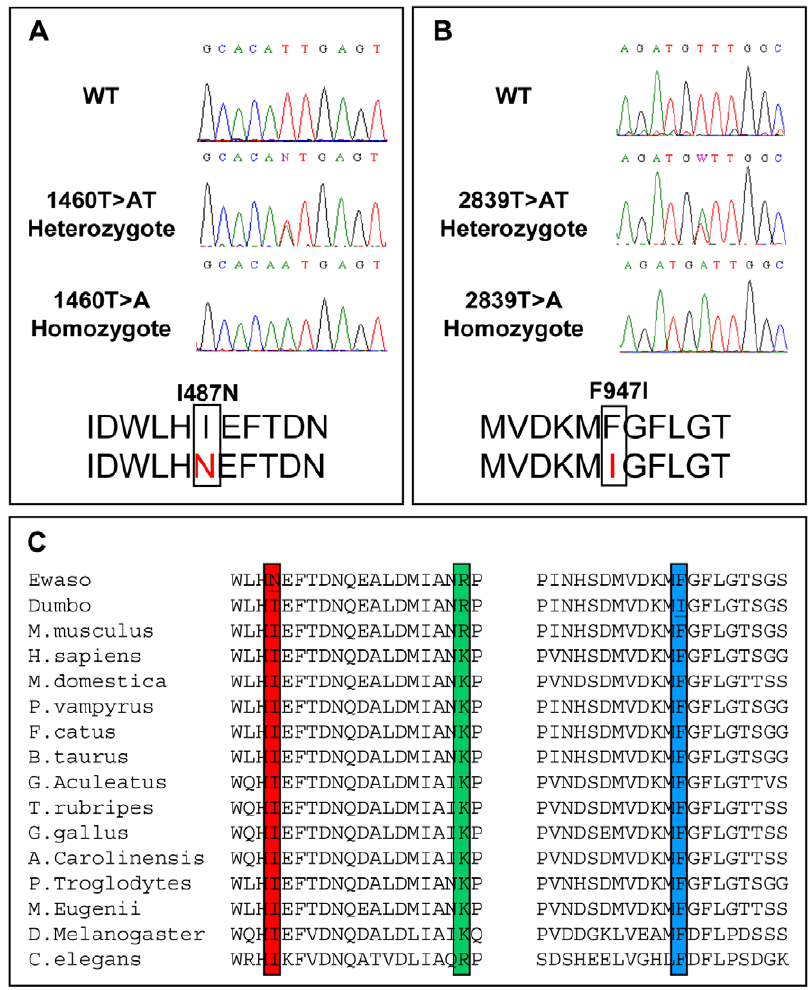
Figure 2. Myo7a mutations identified in Myo7a I487N/I487N ewaso and Myo7a F947I/F947I dumbo strains. ( A ) Direct sequencing identified a 1460T . A (I487N) missense mutation in Myo7a I487N/I487N ewaso and a missense mutation 2839T . A (F947I) in the Myo7a F947I/F947I dumbo mouse strain ( B ). Wildtype and heterozygote sequences are shown for comparison. ( C ) Sequence conservations of Myo7a I487N/I487N ewaso (red) and Myo7a F947I/F947I dumbo (blue) mutations, and the closely positioned Myo7a sh-1 shaker mutation (green) showing high evolutionary conservation of our two mutant strains.